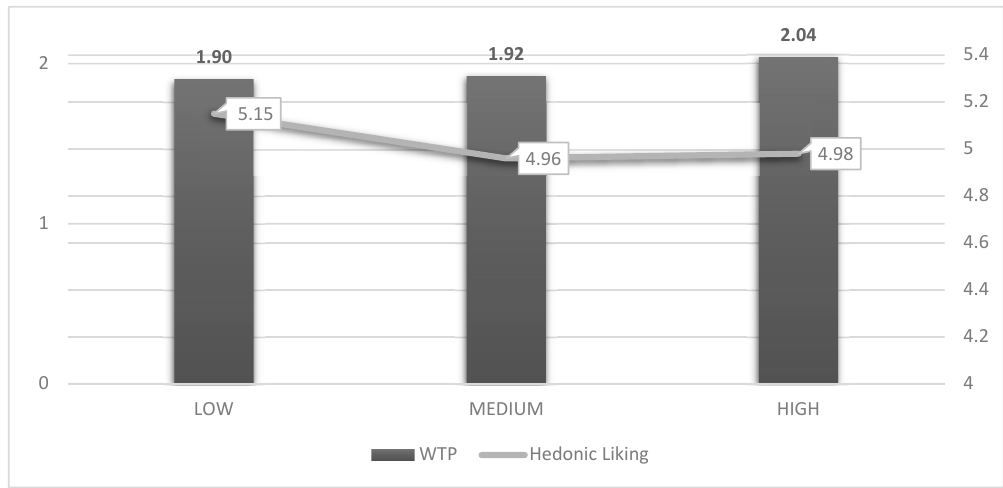
Figure 3. Blind round, mean WTP ( € ) and hedonic liking scores.